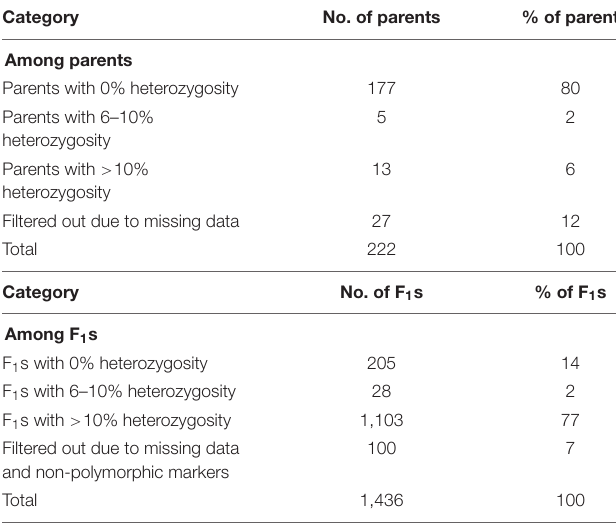
TABLE 3 | Summary level of heterozygosity among parents and F 1